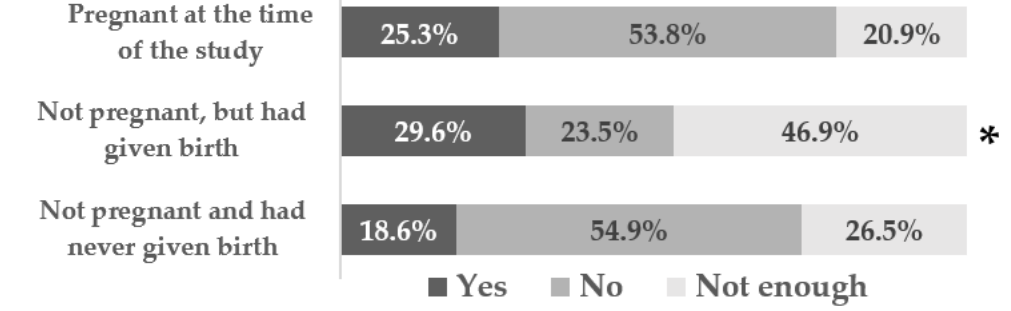
Figure 1. Distribution of answers to the question “Do you have knowledge about exercise for pregnancy” according to the current status of the respondents; *— p < 0.05 comparing first group with second, and second group with third.